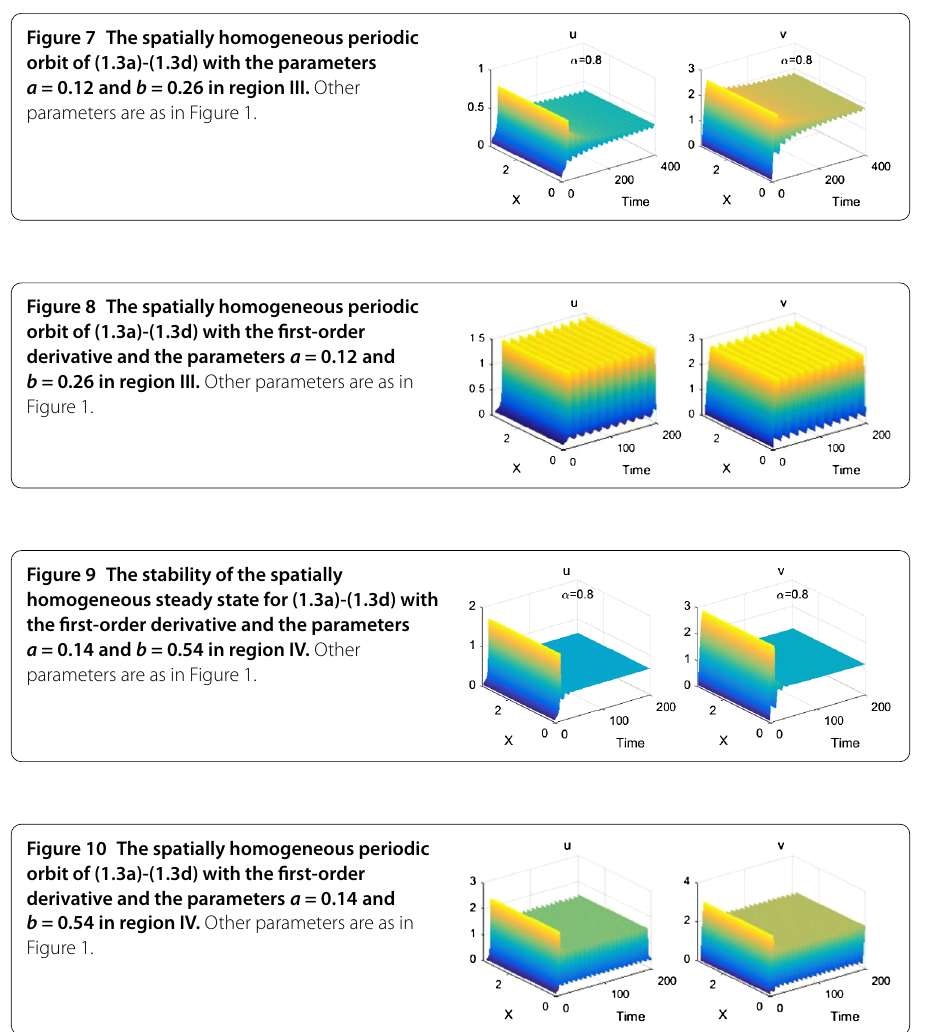
Figure 7 The spatially homogeneous periodic orbit of (1.3a)-(1.3d) with the parameters a = 0.12 and b = 0.26 in region III. Other parameters are as in Figure 1.